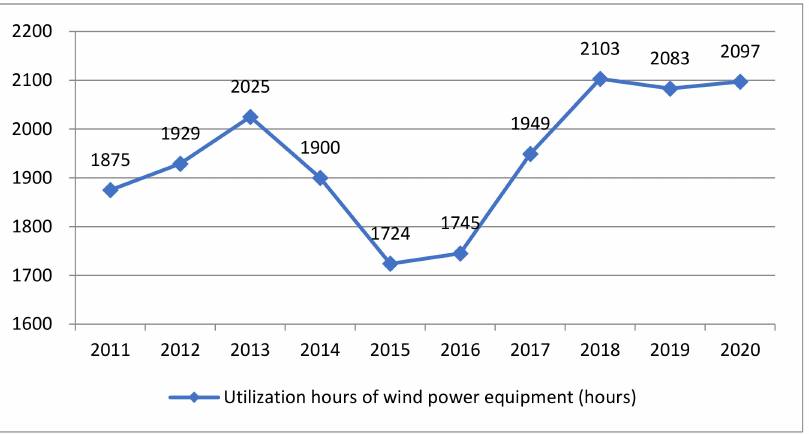
Figure 4. Utilization hours of wind power equipment in China. (Data source: National Energy Administration).